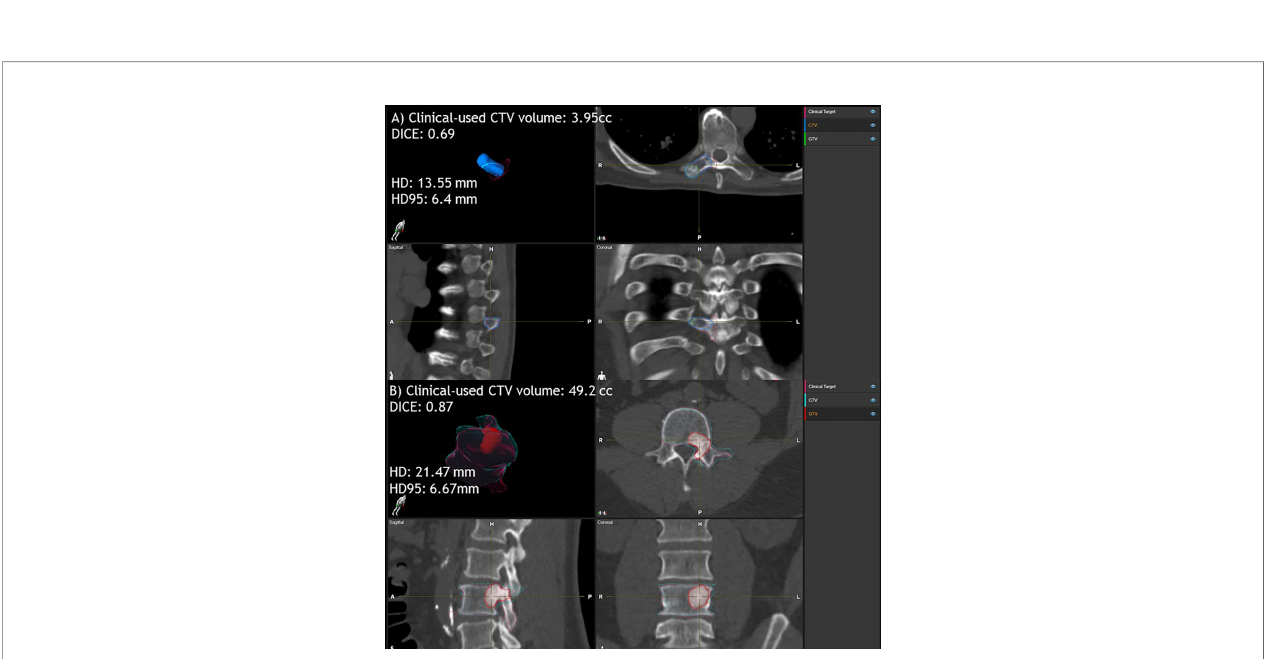
FIGURE 5 | Examples of clinically used CTV and ESS-generated CTV comparison for small and large volumes. Case (A) clinically used CTV volume is 3.95 cc. DICE is 0.69, HD is 13.55 mm and HD95 is 6.4 mm. Case (B) clinically used CTV volume is 49.2 cc. Dice is 0.87, HD is 21.47 mm and HD95 is 6.67 mm. Here, ESS- generated CTV is labeled as Clinical Target.